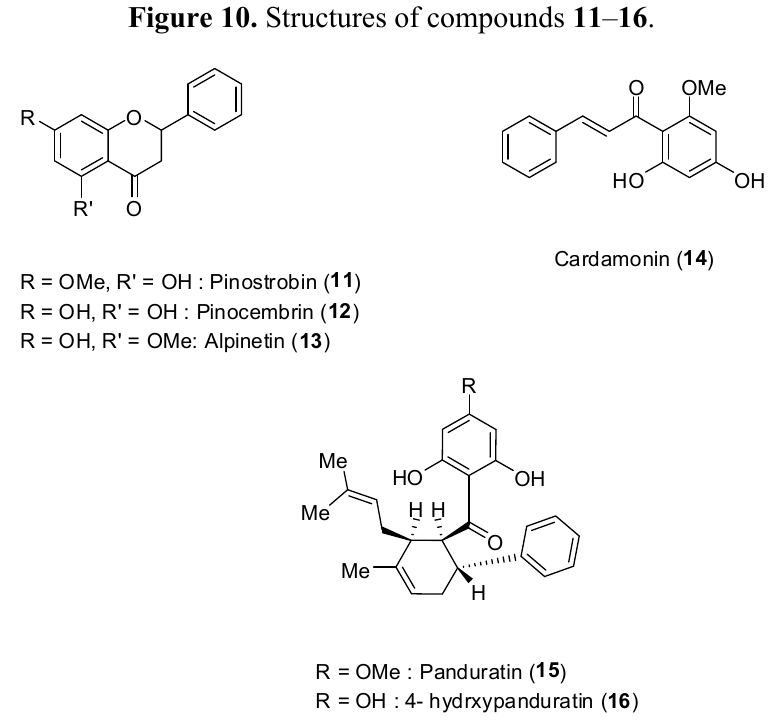
Figure 10. Structures of compounds 11 – 16 .